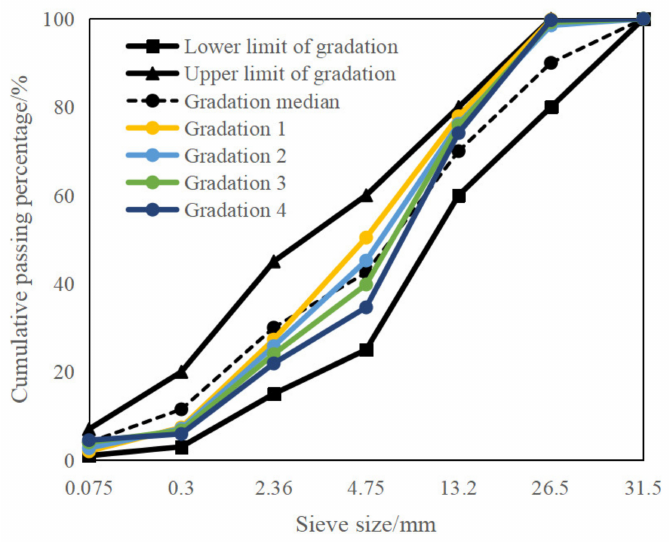
Figure 1. Different gradation types of